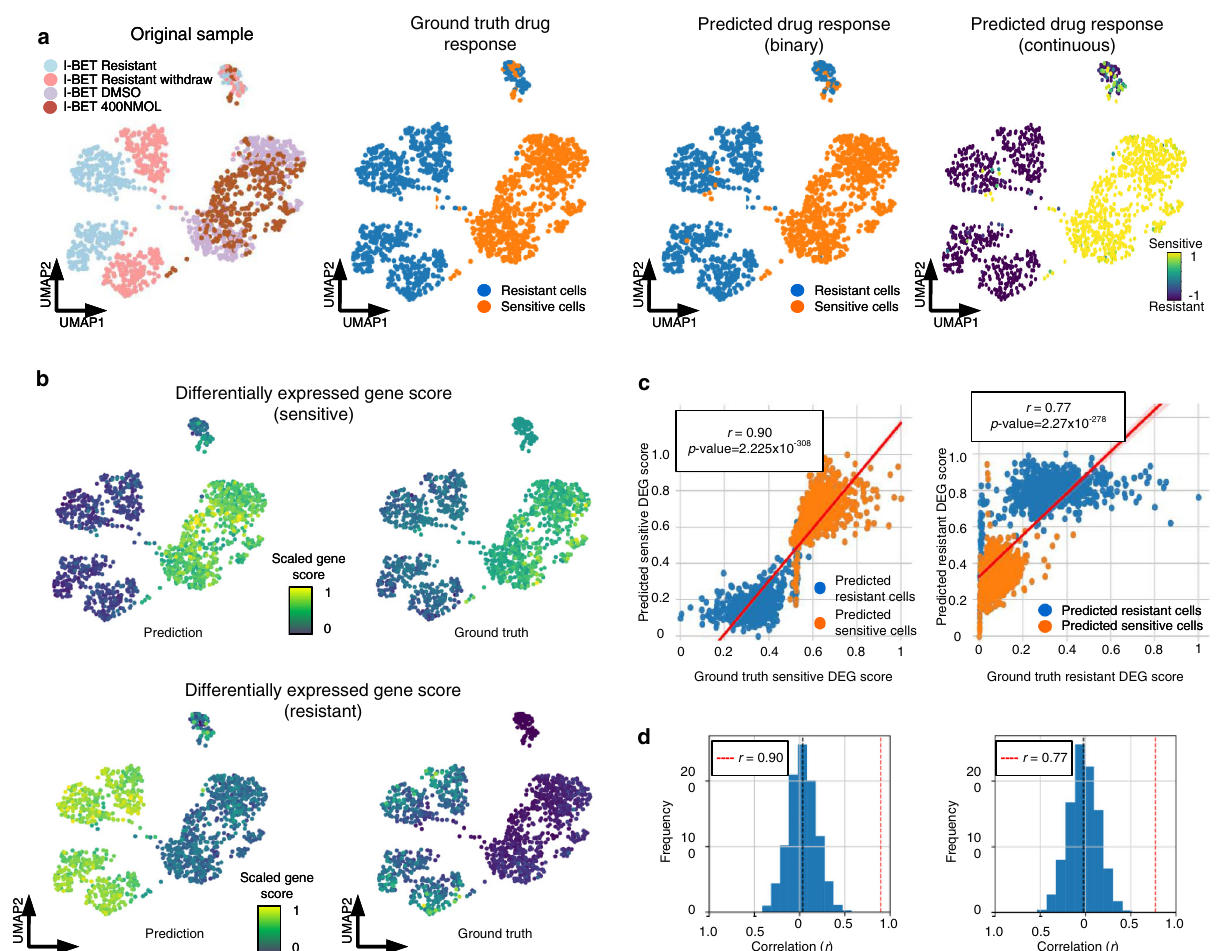
Fig. 3 | Case study of Data 6 corresponding to I-BET treatment. a From left to right: UMAPS visualizations of Data 6 colored by sample treatment types provided in the original study, ground-truth drug-response labels, predicted binary drug response labels, and predicted continuous drug response probability scores. b UMAP plot colored by sensitive (and resistant) gene scores derived from differ- entiallyexpressedgenesinthepredictedandground-truthsensitive(andresistant) cluster. Source data are provided as Source Data 7: sensitive and resistant DEG scores in predictedand ground truth sensitive and resistancecells in Data 6. c The